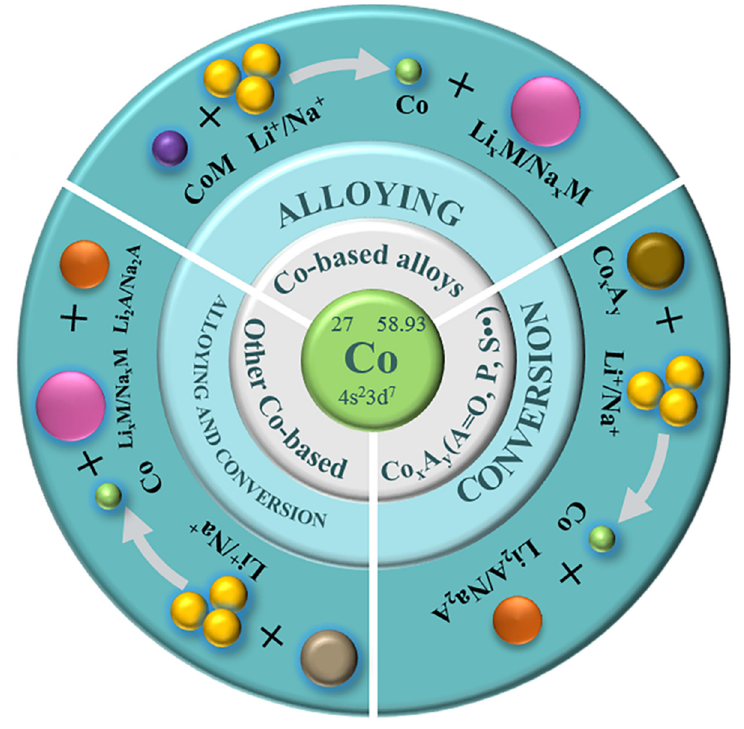
Figure 1. Li + / Na + storage mechanisms for di ff erent Co-based